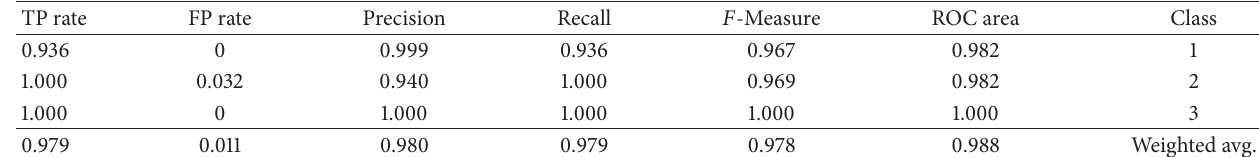
Table 3: Detailed accuracy by class (10-fold cross validation).